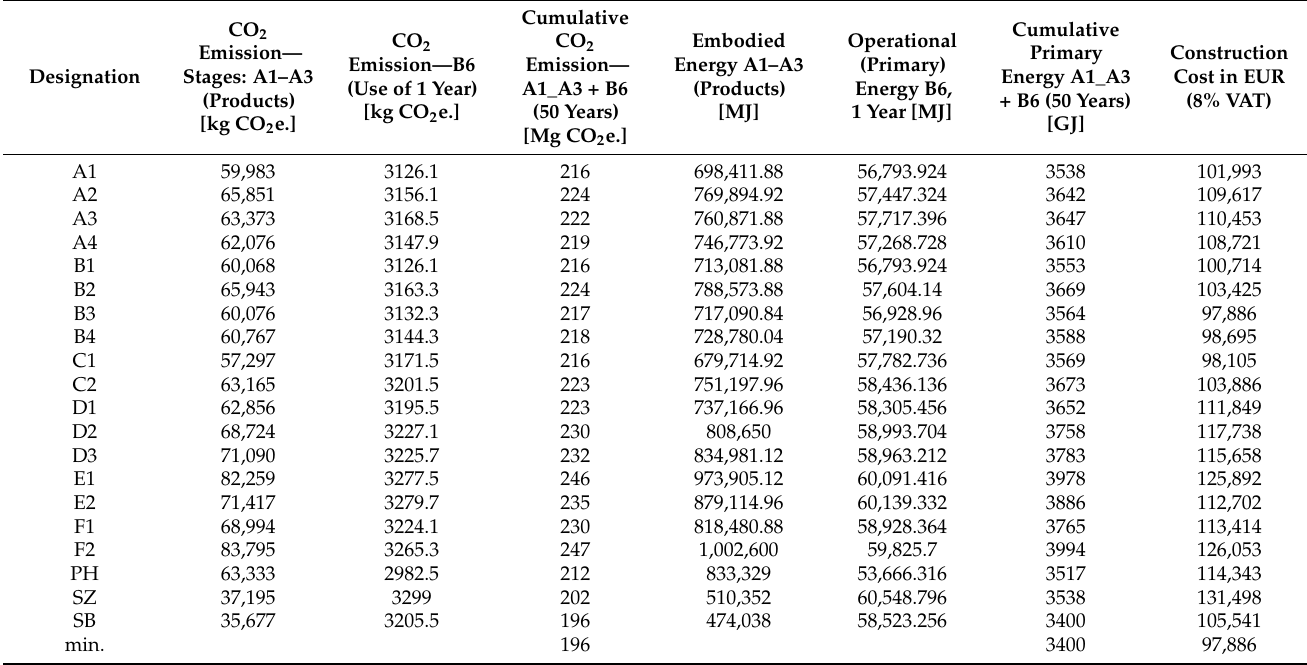
Table 7. Results of embodied carbon emission and embodied energy calculations for respective building